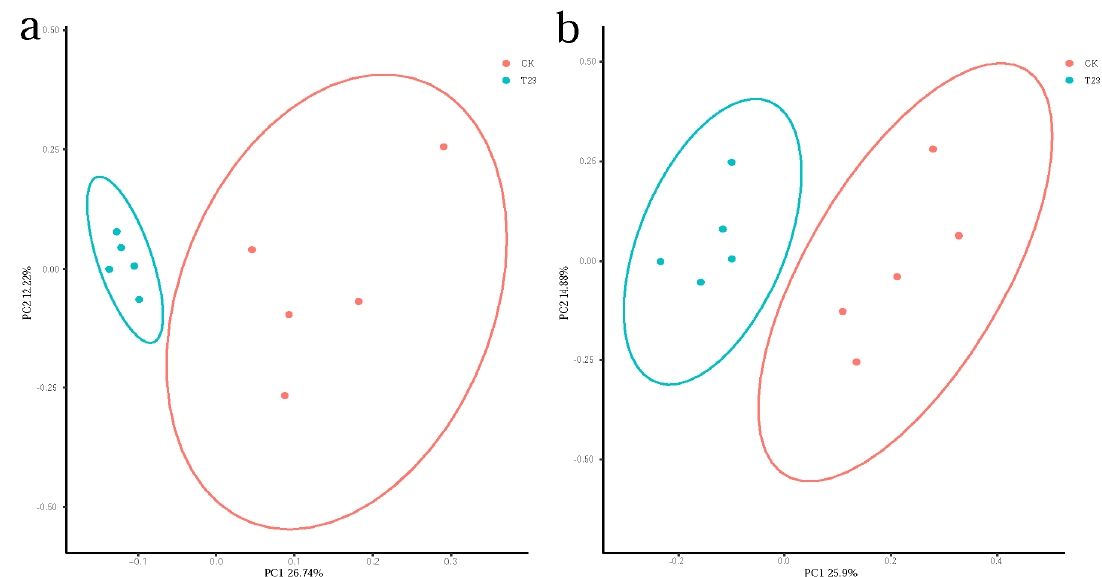
Figure 2. Effect of T. viride T23 on the beta diversity of soil bacterial ( a ) and fungal ( b ) communities, respectively, using principal coordinate analysis (PCoA). Blue dots represent the T. viride T23 group and orange dots represent the control group.